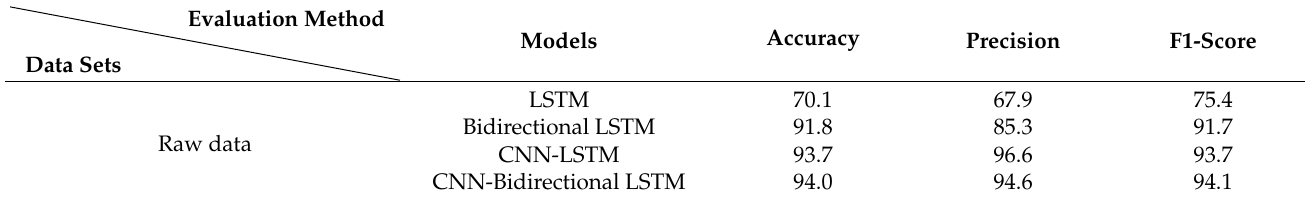
Table 3. DL models’ accuracy, precision, and F1-score based on raw values.